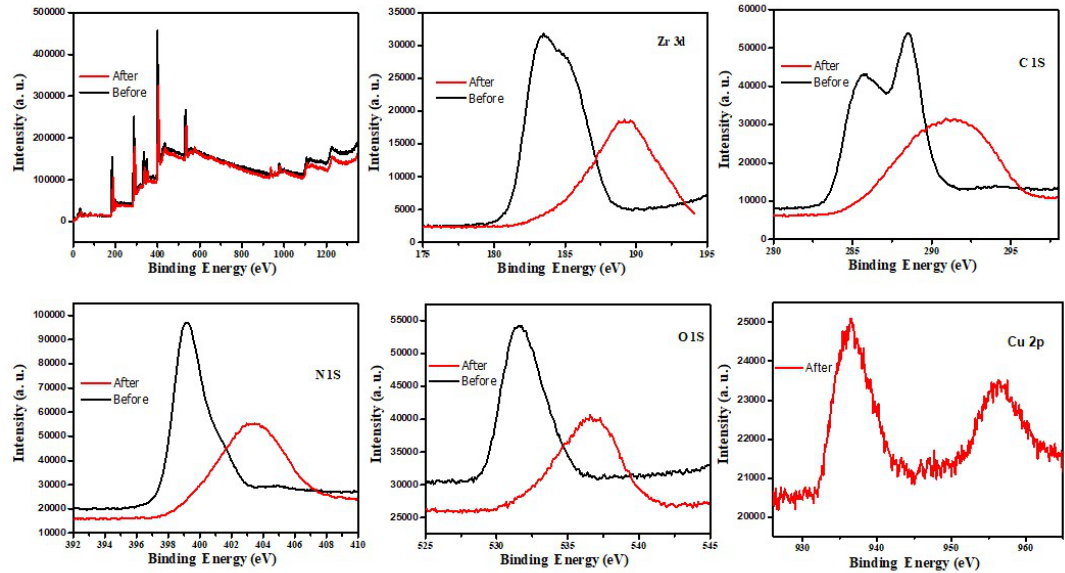
Figure 8. The XPS of the Zr-G-C 3 N 4 before and after Cu ions adsorption. The results obtained by FTIR, XPS, and SEM/EDS elemental mapping demonstrate that functional groups of Zr-G-C 3 N 4 (OH, and -NH 2 ) and p-delocalized electrons of the triazine ring (C 3 N 3 ) are most probably involved in the elimination of Cu (II). The plausible adsorption mechanism of Cu 2+ ions by Zr-G-C 3 N 4 nanomaterial is illustrated in Figure 9.